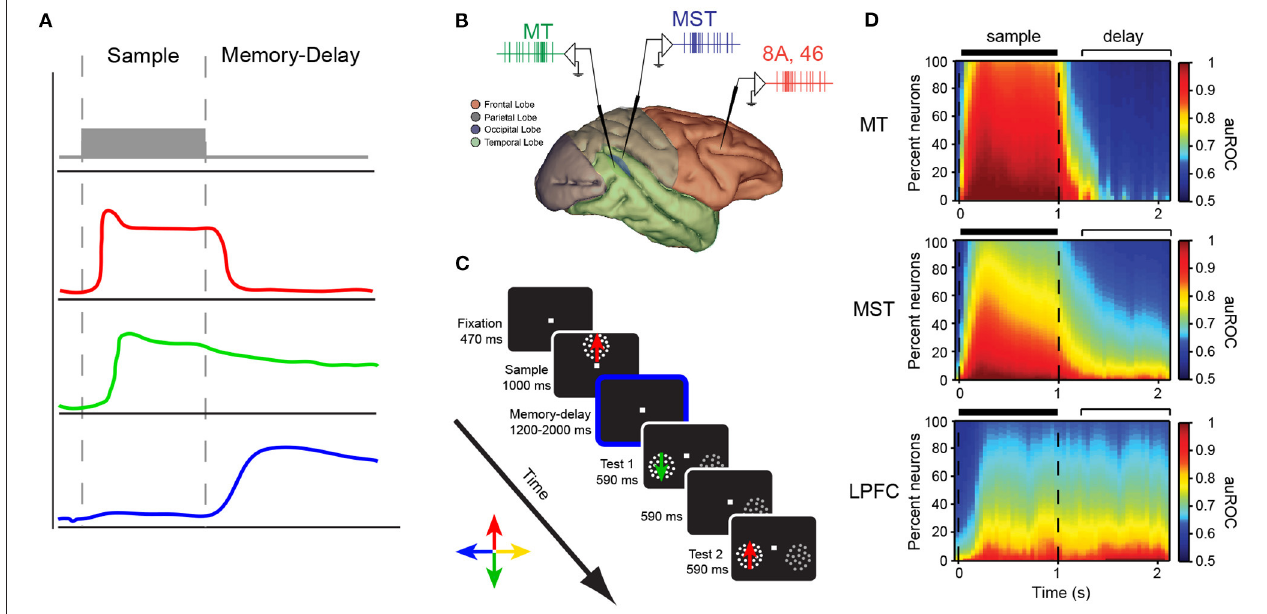
FIGURE 2 | (A) Different response profiles of neurons in the LPFC of macaque monkeys during the sample and delay periods of a delayed response task. (B) Recording locations in the study of Mendoza-Halliday et al. (2014). MT (green), MST (blue), LPFC areas 8A/46 (red) during a match-to-sample task for motion direction (C) . (D) The proportion of neurons showing encoding of motion direction during the sample and delay period of the task in the three areas. The color scale represents the strength of direction selectivity quantified by the area under the receiver operating characteristic curve (auROC).